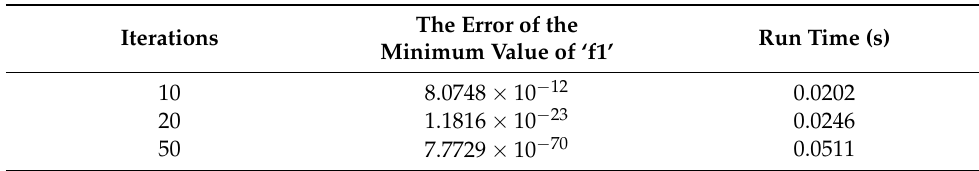
Table 3. The sensitivity analysis of the iterations.